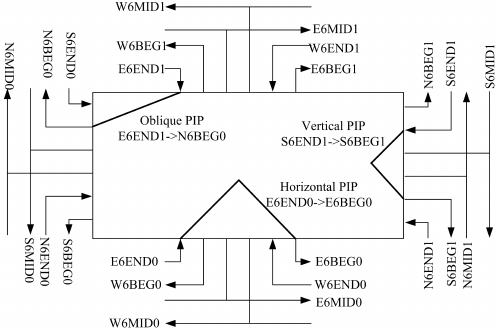
Figure 4. Hex lines and hex PIPs.